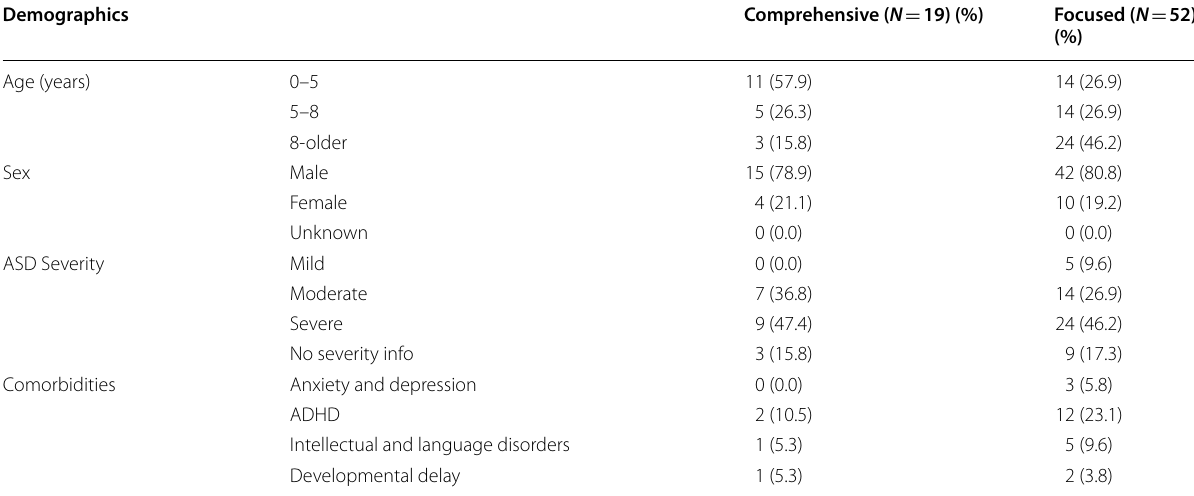
Table 3 Demographics table showing the breakdown of the patients in the hold-out test dataset based on the age, sex, and ASD severity. The table also shows the distribution of various comorbidities between the two types of ABA treatment plans